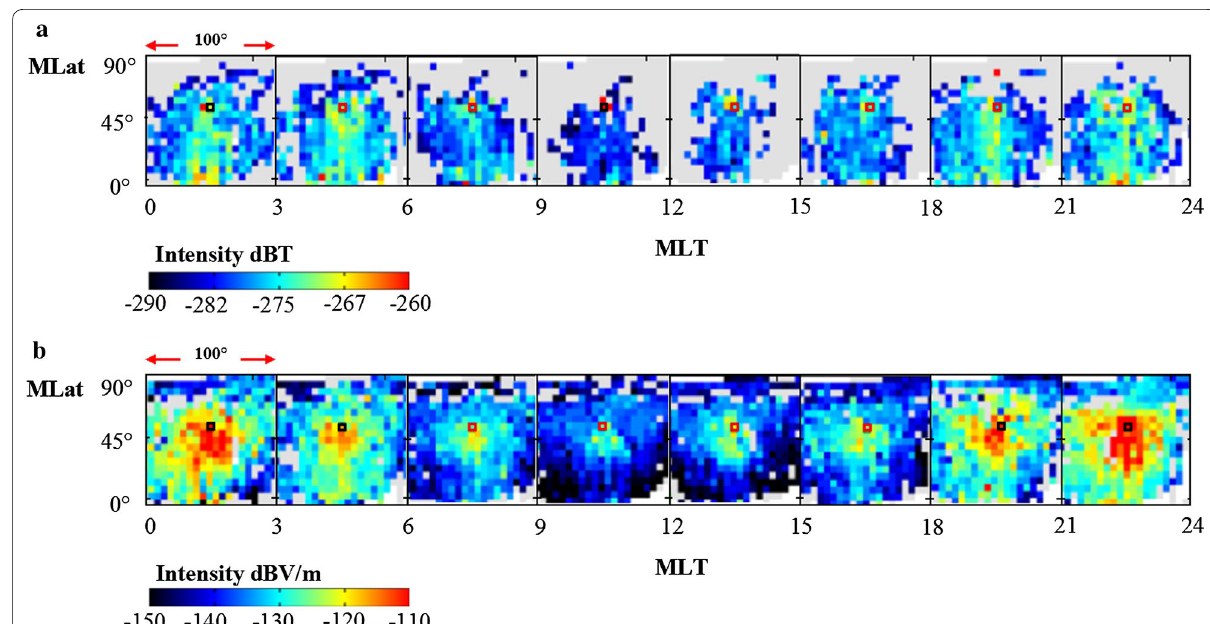
Fig. 7 a Propagation of the Omega signal from the North Dakota station based on local time in the magnetic field and b in the electric field: the red arrow indicates the width of the map (~100°) with the station in the center (indicated by the rectangle )